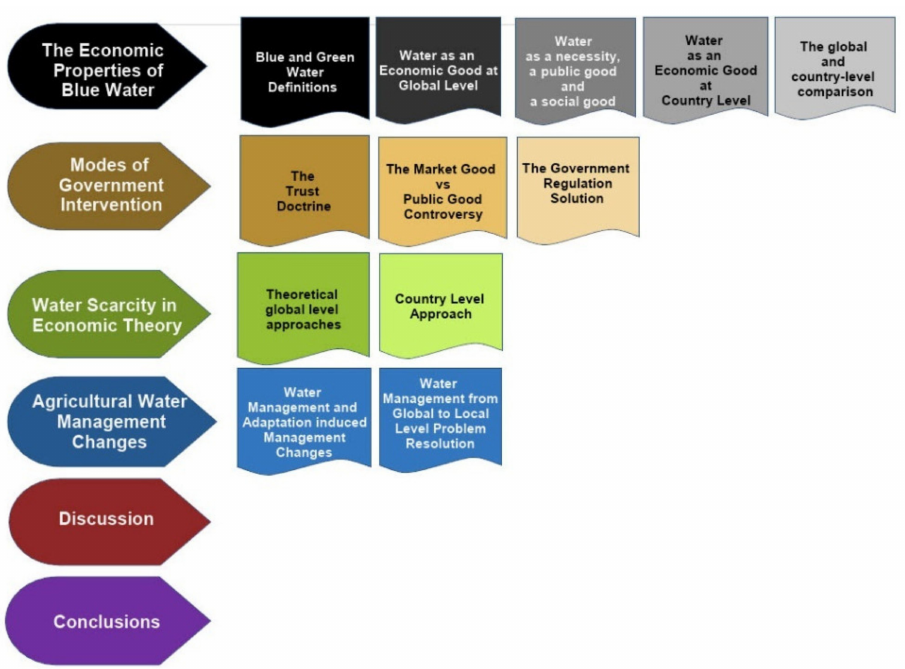
Figure 2. Structure of the